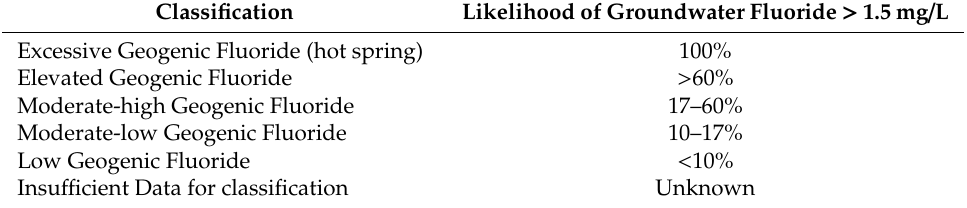
Table 3. Fluoride classifications and likelihood (%) of encountering groundwater fluoride > 1.5 mg / L. Hot springs represent site-specific groundwater fluoride sources; all other classifications represent generic